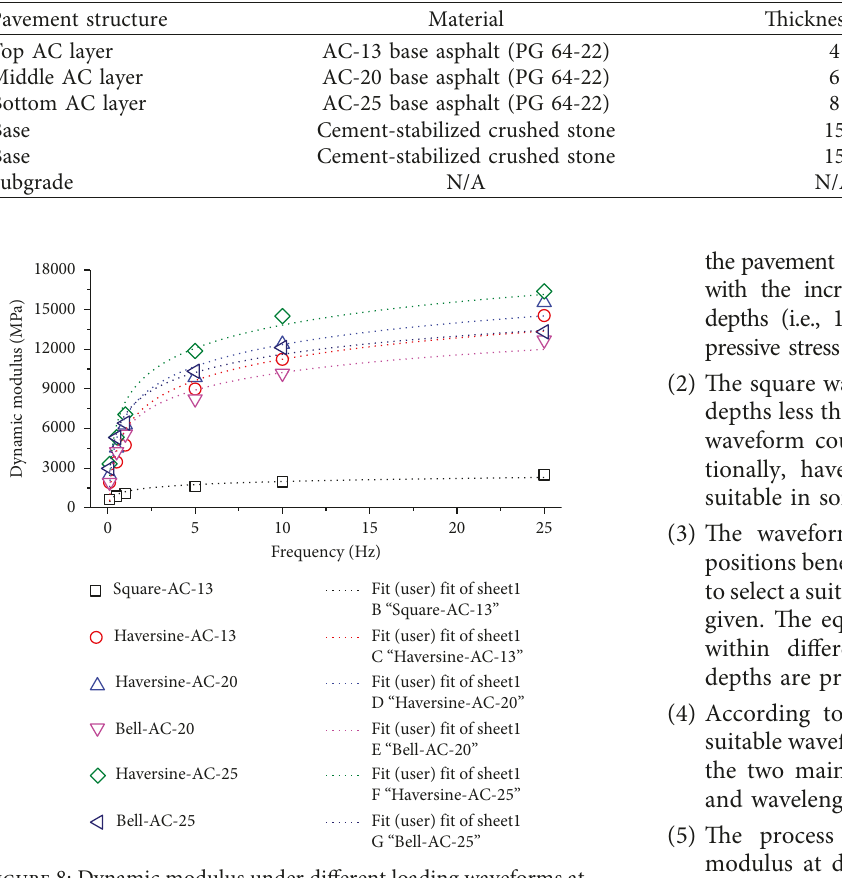
Figure 8: Dynamic modulus under different loading waveforms at 21 °